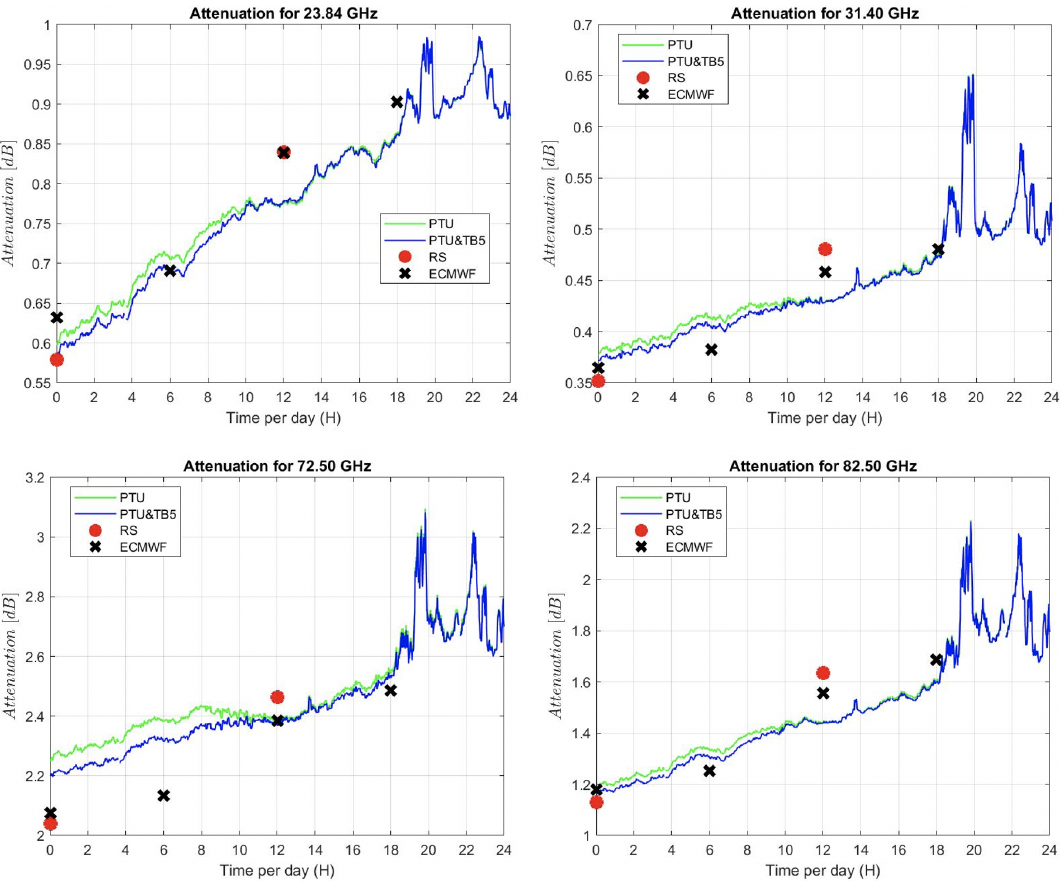
Figure 6. The 24h time series (31 December 2018) of A from the PTU (green line) and PTU with T B (blue line) methods. A computed from twice-daily radiosonde measurements (red dots) and ECMWF analysis (black crosses) is also reported. Clockwise from top left: 23.84, 31.40, 72.50,